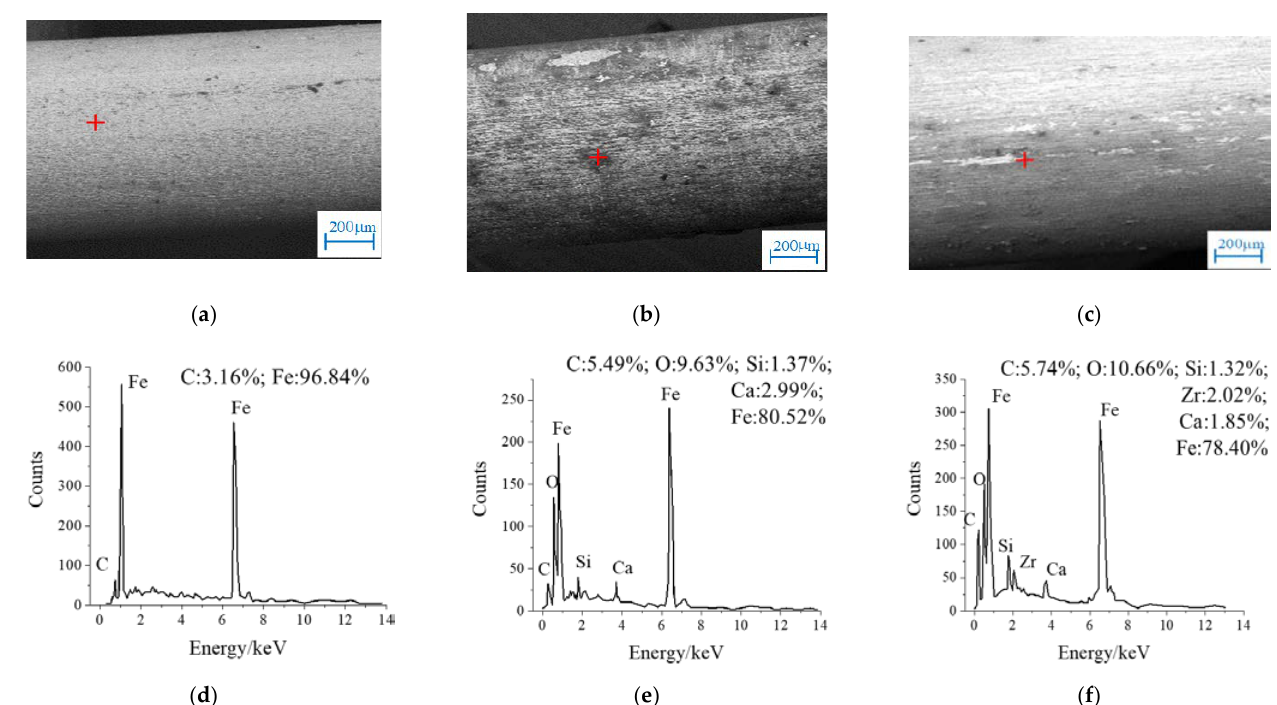
Figure 11. SEM micrographs and EDS spectra of steel fibres before pullout tests: ( a ) A micrograph of group U; ( b ) A micrograph of group Z1; ( c ) A micrograph of group ZZ1; ( d ) EDS spectra of group U; ( e ) EDS spectra of group Z1; ( f ) EDS spectra of group ZZ1.